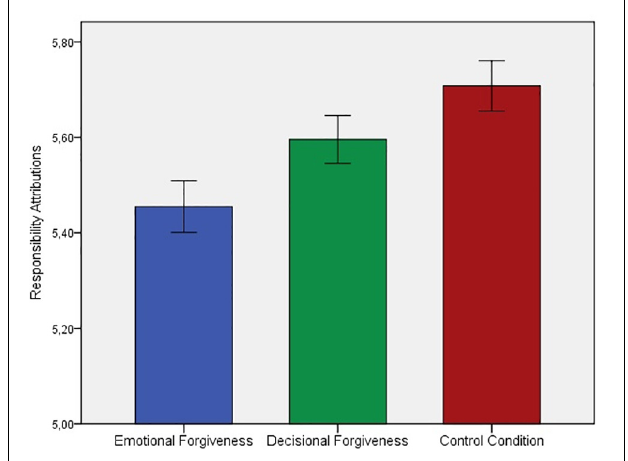
FIGURE 1 | Responsibility attributions as a function of forgiveness manipulation. Standard errors are indicated by vertical